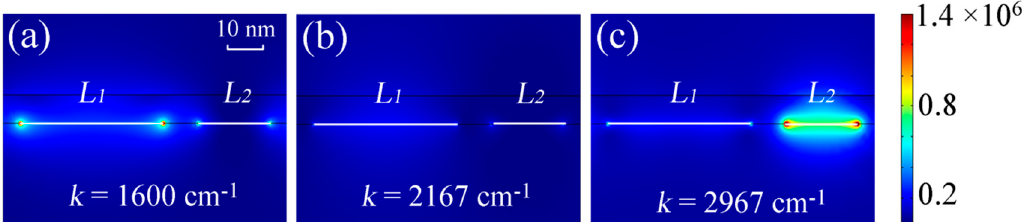
Figure 3. Side view of electric field distributions of MRGB with protein and lipid at some specific wavenumbers for ( a ) k = 1600 cm − 1 , ( b ) k = 2167 cm − 1 , ( c ) k = 2967 cm − 1 under normal TM incidence, where L 1 = 40 nm, L 2 = 20 nm, t 1 = 280 nm, t 2 = 500 nm, p = 80 nm, E F 1 = 0.55 eV, E F 2 = 0.85 eV. The white lines denote the outline of GNRs.